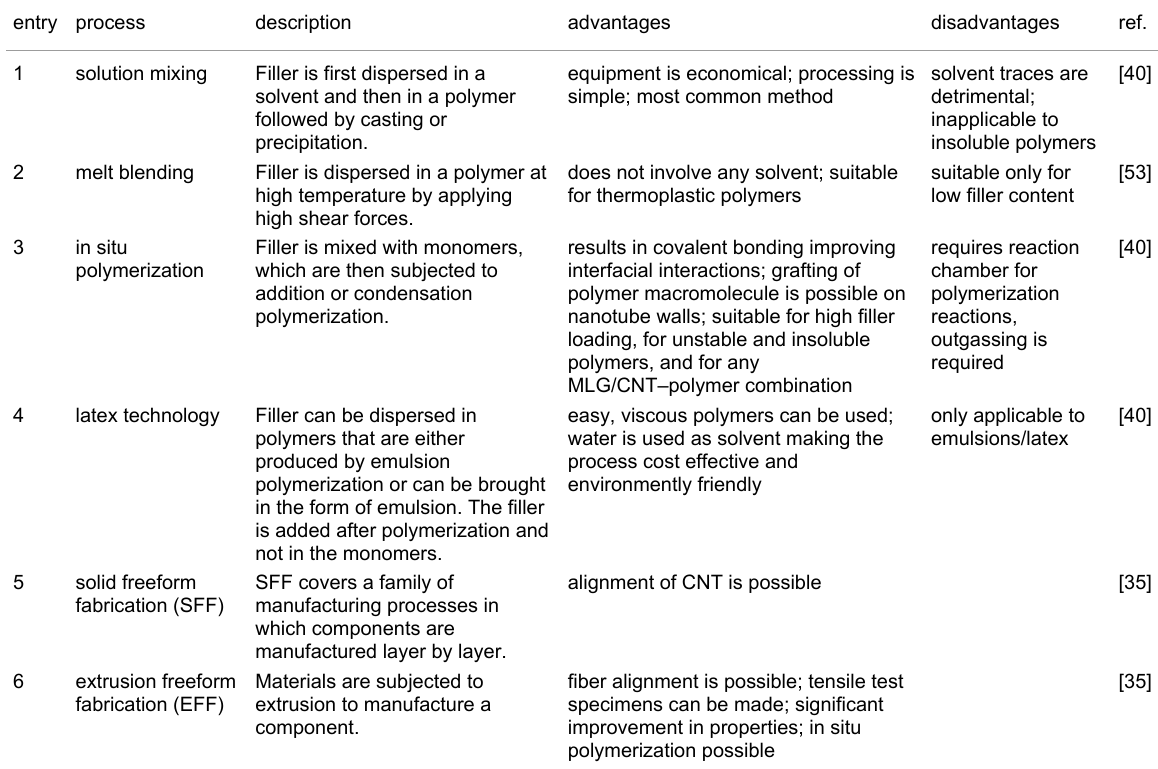
Table 4: Various production routes for polymer